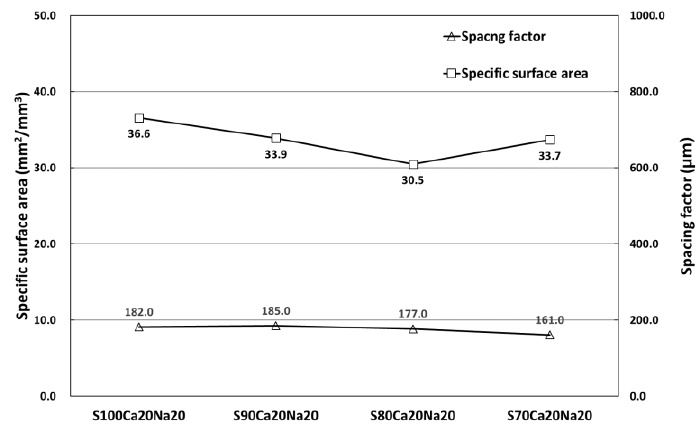
Figure 10. Image analysis experiment results.